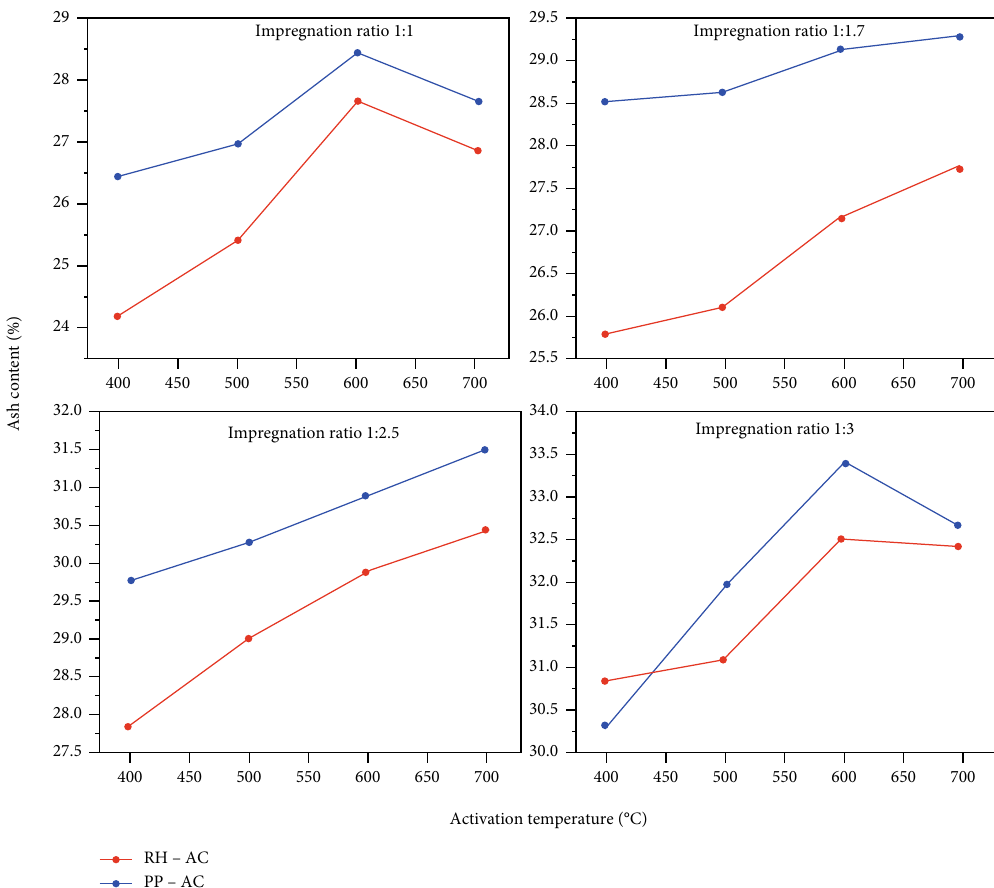
Figure 2: The e ff ect of the impregnation ratio and activation temperature on the ash